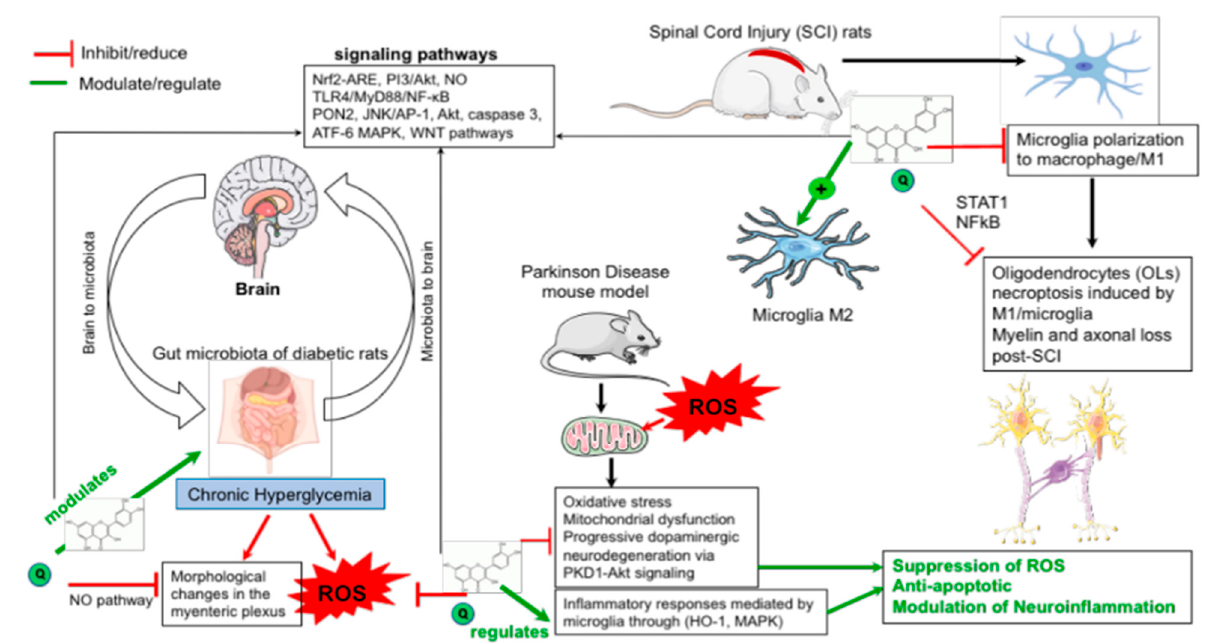
Figure 1. Protective effects of quercetin through modulating microbiota and reactive oxygen species levels to prevent neurological disorders. Quercetin exerts its indirect neuroprotective effect through microbiota involving reactive oxygen species (ROS) pathways suppression in diabetic peripheral neuropathy rats. It regulates cytoprotective protein expression against ROS-induced oxidative stress and suppresses neuroinflammatory responses induced by ROS. Quercetin inhibited inflammatory responses in microglial cells and up-regulate heme oxygenase-1 (HO-1) against endotoxic stress through MAPKs.